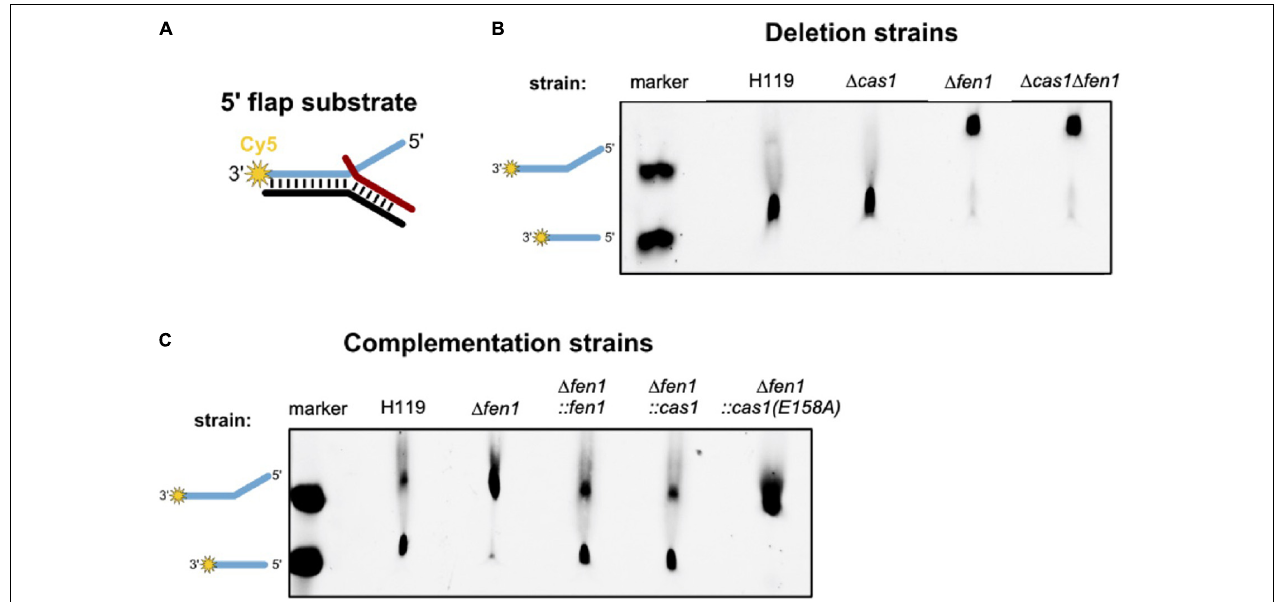
FIGURE 5 | In vitro processing of a 5 (cid:48) flap DNA substrate. Cell extracts of Haloferax volcanii wild-type and deletion strains were prepared and incubated with a 5 (cid:48) flap DNA substrate. (A) Representation of the 5 (cid:48) flap substrate, which was labelled with Cy5 (yellow star) at the 3 (cid:48) end of the flapped (+) strand. (B) Denaturing PAGE showing the DNA processing activity of cell extracts of the deletion strains. Lane marker: full length Cy5 labelled oligonucleotide as shown in A and Cy5 labelled oligonucleotide corresponding to the processed product; lanes H119, (cid:49) cas1 , (cid:49) fen1, (cid:49) cas1 (cid:49) fen1 : soluble extracts from respective strains. (C) Denaturing PAGE showing the processing activity of cell extracts of the deletion strains complemented with the genes for Fen1, Cas1 or the Cas1 mutant. Shown are representative gels of three independent